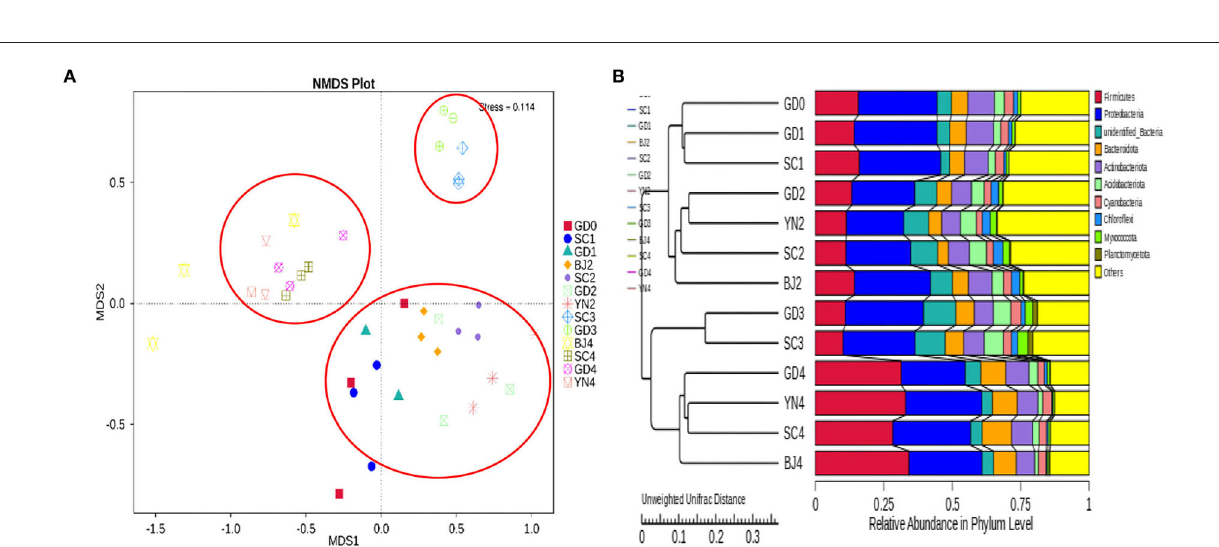
FIGURE 9 | (A) NMDS analysis of fungal community composition. Each point represents a sample, plotted by the second principal component on the Y-axis and the first principal component on the X-axis, which was colored by group. (B) UPGMA clustering tree based on weighted UniFrac distance. UPGMA clustering tree (at left). The relative phylum-level abundance map (at